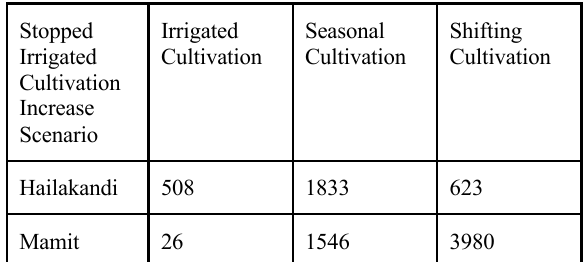
Table 6. Number of land parcels of 25 ha each under various